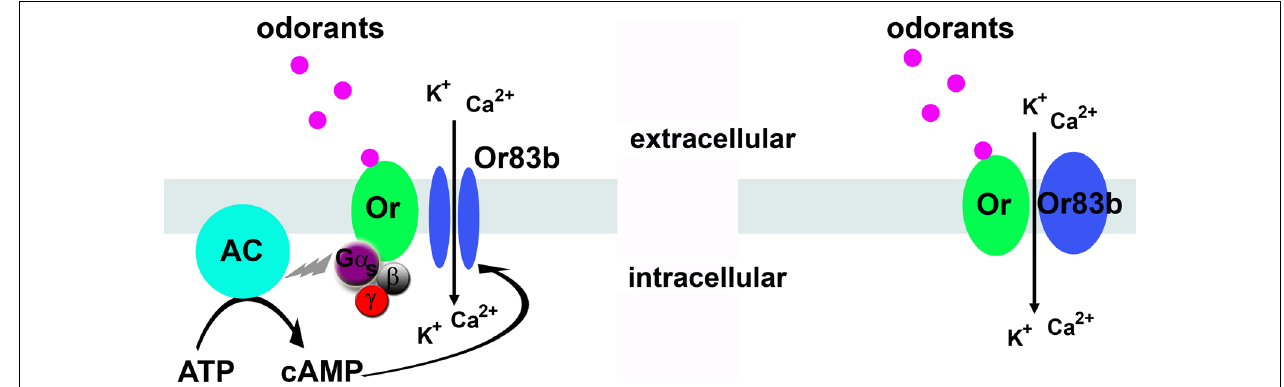
FIGURE 2 | Two possible models for odorant-gated channels. Left, possible role for G-protein mediated cyclic nucleotides in Or83b activation. Right, direct odorant gating of the Or/Or83b receptor complex. The major monovalent cation in the sensillum lymph is